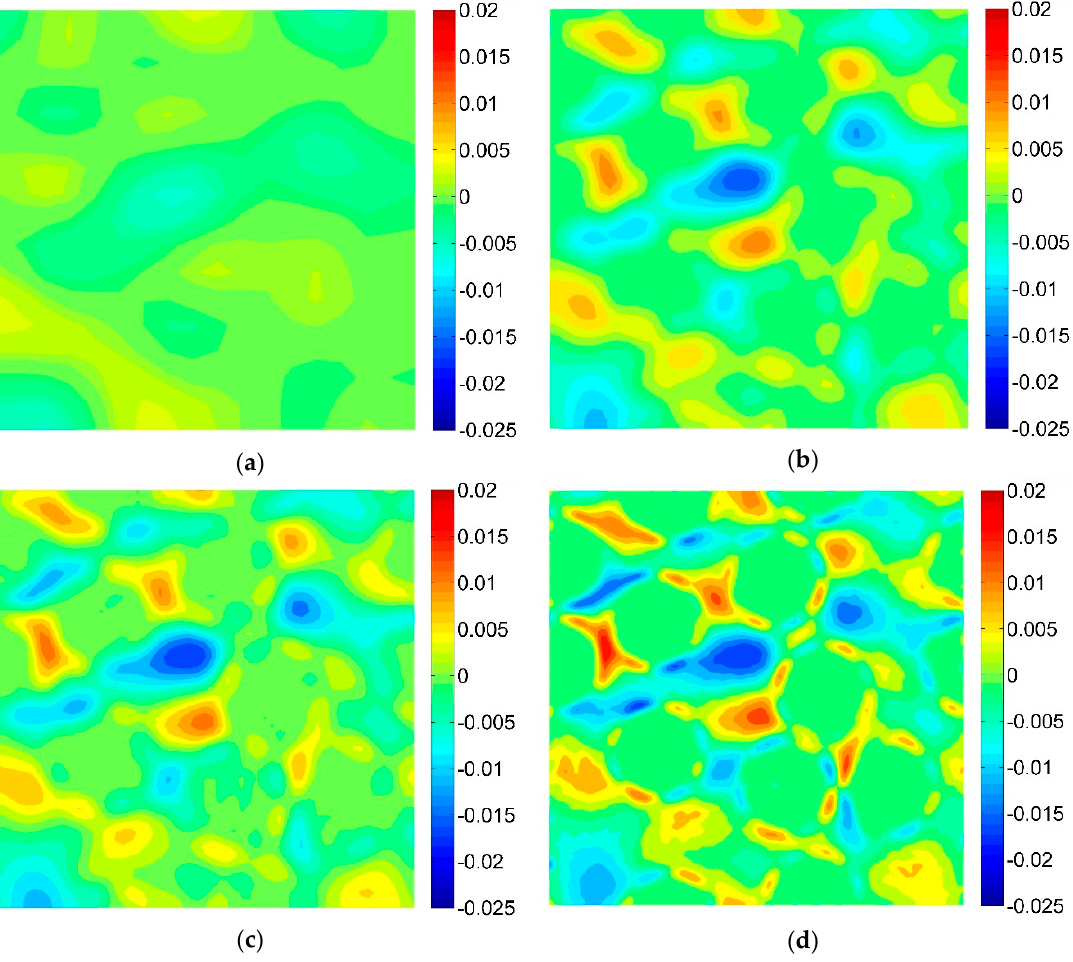
Figure 15. Distribution of strain ε 12 obtained for Material 2 with consideration of different speckle sizes, grid of squares: ( a ) 50 × 50, ( b ) 100 × 100, ( c ) 150 × 150, ( d ) 200 × 200.